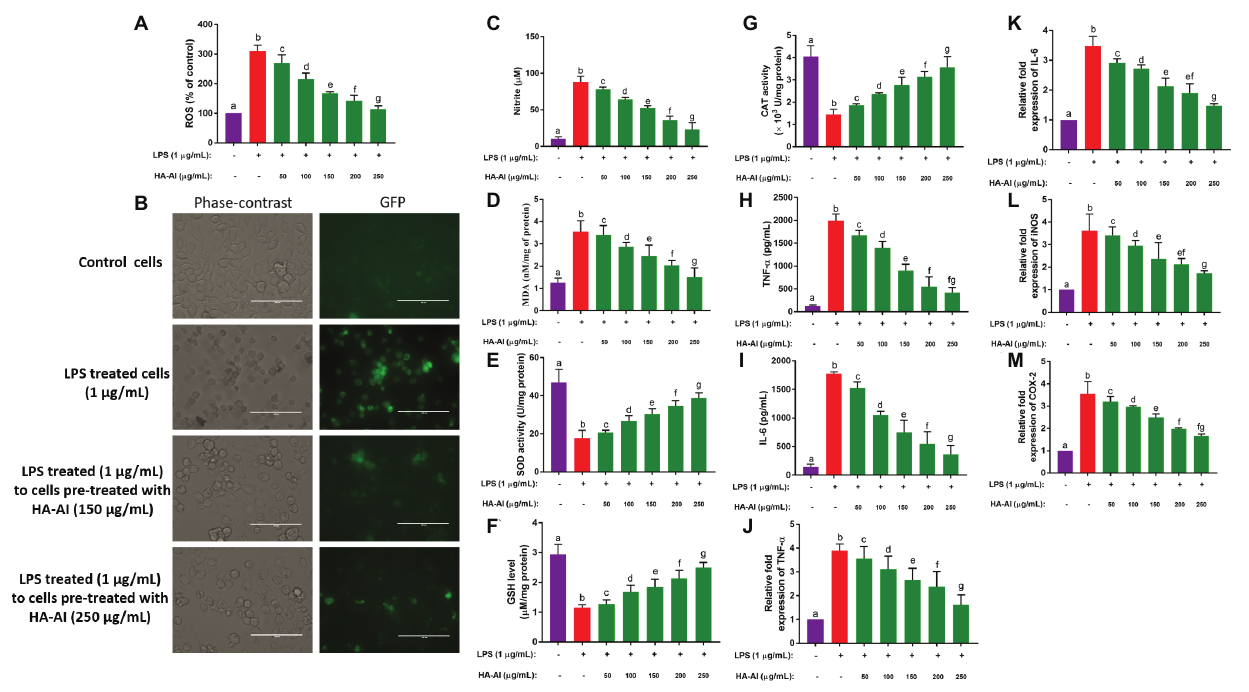
FIGURE 8 | Assessment of protective efficacy of hydroxyapatite– A. indica (HA-AI) composite on LPS-induced oxidative and inflammatory stress in RAW 264.7 cells. (A) Dose-dependent protective efficacy of HA-AI composite on LPS-induced intracellular ROS generation by DCFH-DA staining. (B) Phase contrast and fluorescent microscopic images depicting the protective efficacy of HA-AI composite on LPS-induced intracellular ROS generation by DCFH-DA staining. The scale bar is 100 μm. (C) Dose-dependent protective efficacy of HA-AI composite on LPS-induced nitrite generation. (D) Dose-dependent protective efficacy of HA-AI composite on LPS-induced lipid peroxidation. (E–G) Dose-dependent protective efficacy of HA-AI composite on LPS-induced detrimental effect on antioxidant enzymes, i.e. SOD, GSH, and CAT. (H,I) Dose-dependent protective efficacy of HA-AI composite on LPS-induced inflammatory cytokines (TNF- α and IL-6) by ELISA. (J–M) Dose-dependent protective efficacy of HA-AI composite on LPS-induced inflammation regulatory genes (TNF- α , IL-6, iNOS, and COX-2) by real-time PCR analysis. The experiments were performed individually in six replicates and achieved results were stated as mean ± standard deviation. The data were statistically evaluated by one-way ANOVA following Tukey’s post hoc multiple comparison test. The statistical variance among the experimental groups was measured as significant at p < 0.05. The columns with different alphabets were significant within the respective